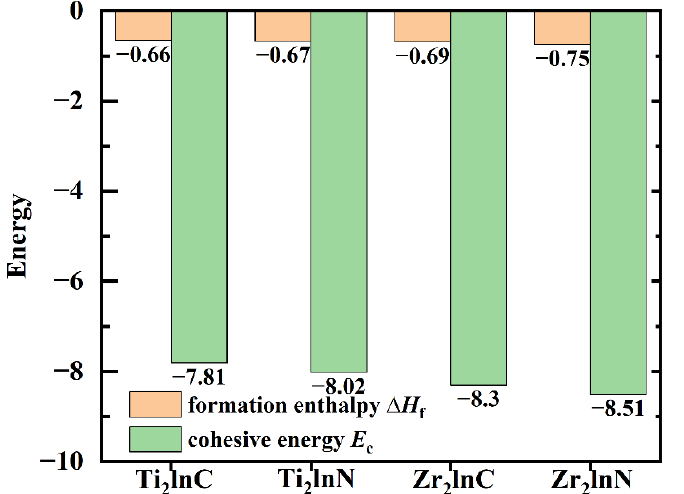
Figure 2. The cohesive energy E c (in eV/atom) and formation enthalpy ∆ H f (in eV/atom) of M 2 InX